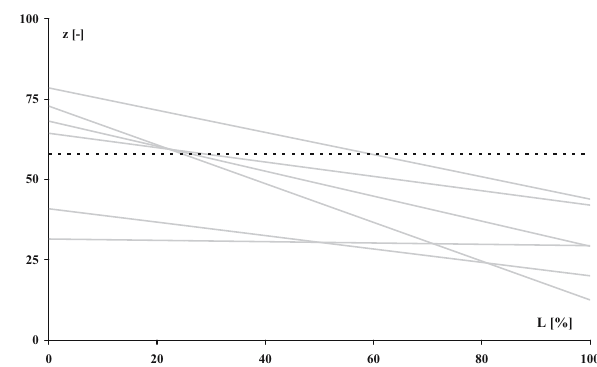
Figure 10: Comparison of the dependence of the braking e ffi ciency index on the relative position of the driver ’ s seat for individual examined persons for the Skoda